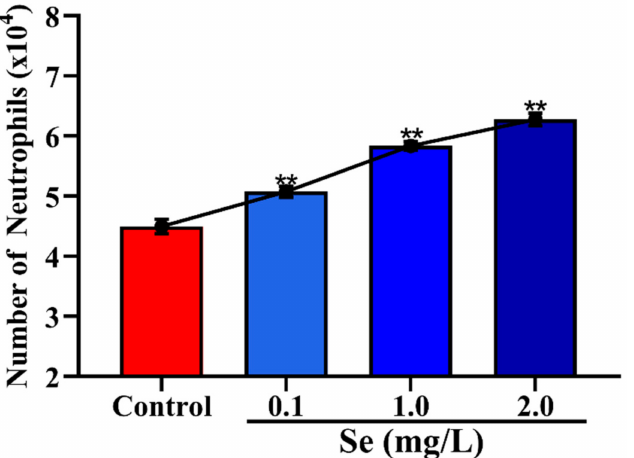
Figure 5. Effects of Se on the migration of neutrophils in the trans-mammary epithelium. ** p < 0.01 between the different concentrations of Se (0.1, 1.0 and 2.0 mg/L) group and the control group in the same batch. Each value represents the mean ± SEM, n =